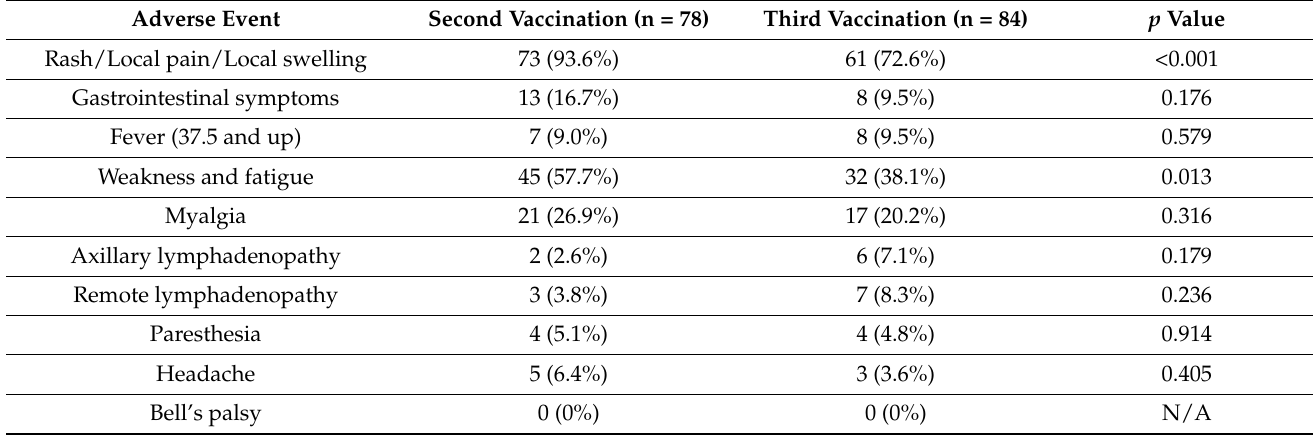
Table 2. Adverse events after BNT162b2 vaccine in 78 pregnant women who received a second dose and 84 pregnant women who received a third (booster)